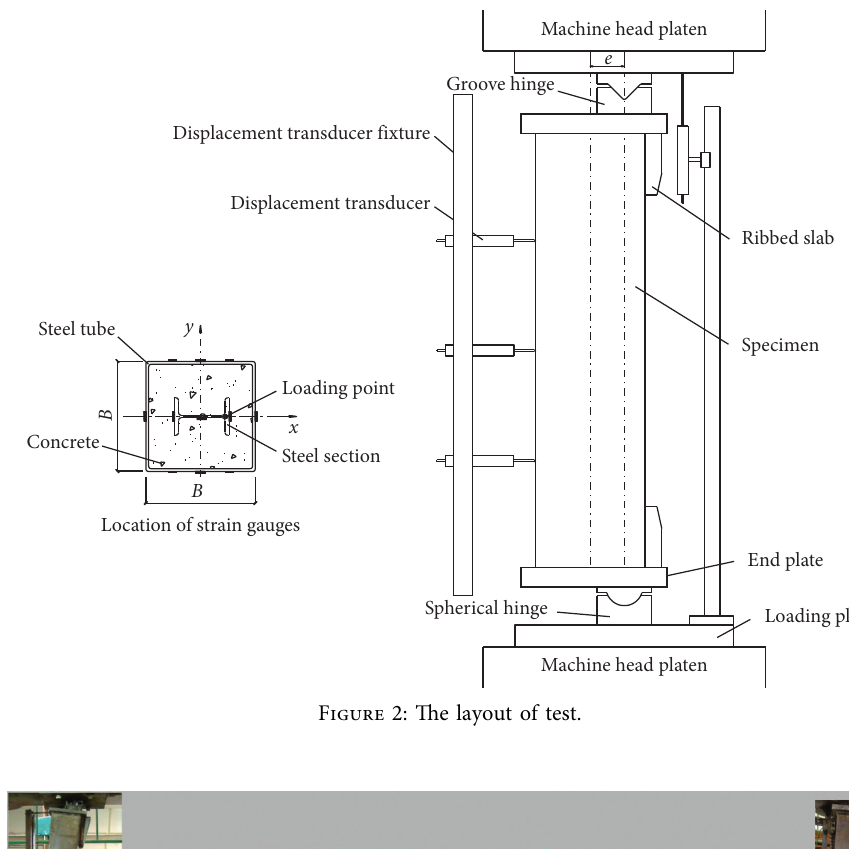
Figure 2: The layout of test.